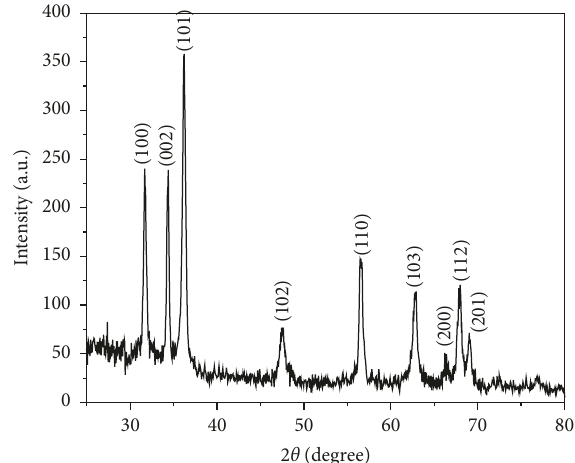
Figure 2: X-ray diffraction patterns of